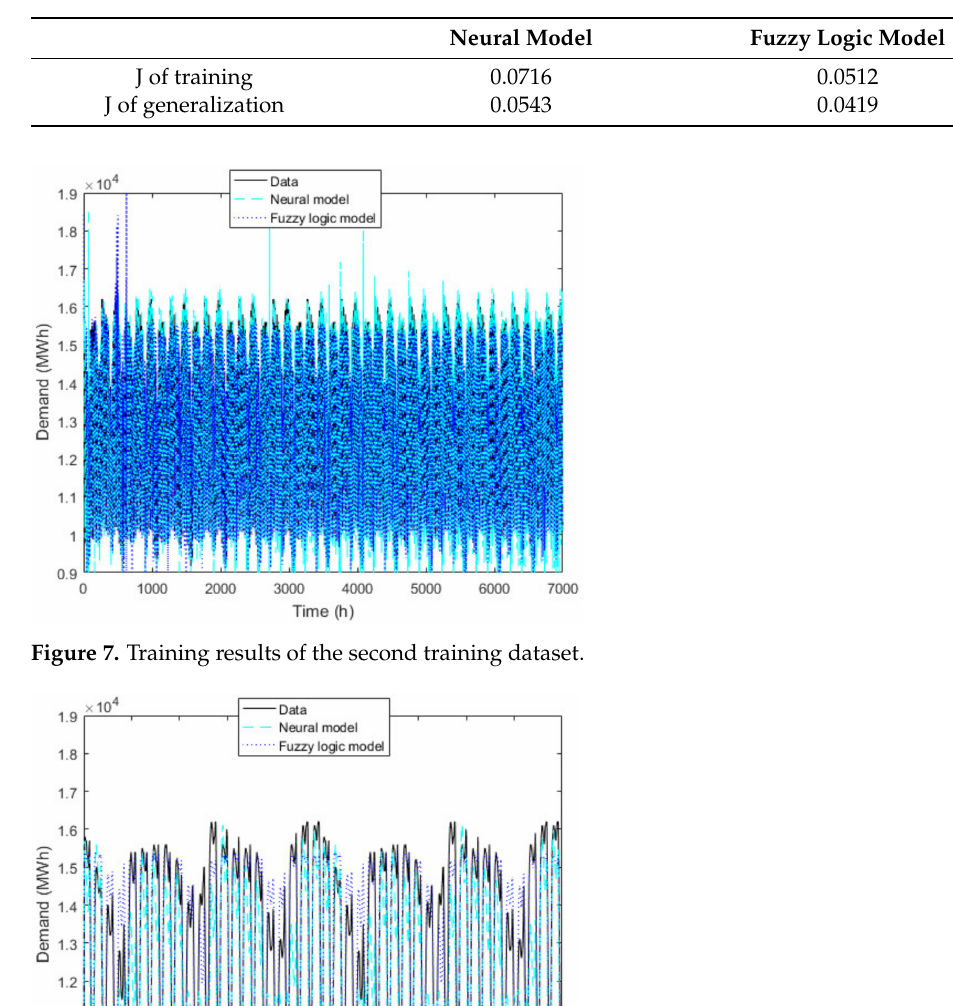
Figure 6. Generalization costs of the first training dataset. Table 2. Costs for the first training dataset.